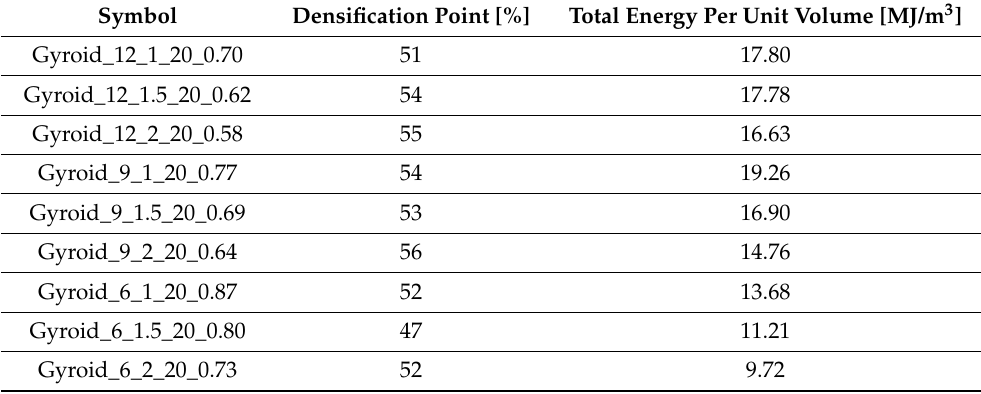
Figure 11. Energy absorption per unit volume of tested cylindrical mapped gyroid structures. Table 5. Densification point and total energy per unit volume absorbed up to densification point of the tested cylindrical mapped gyroid